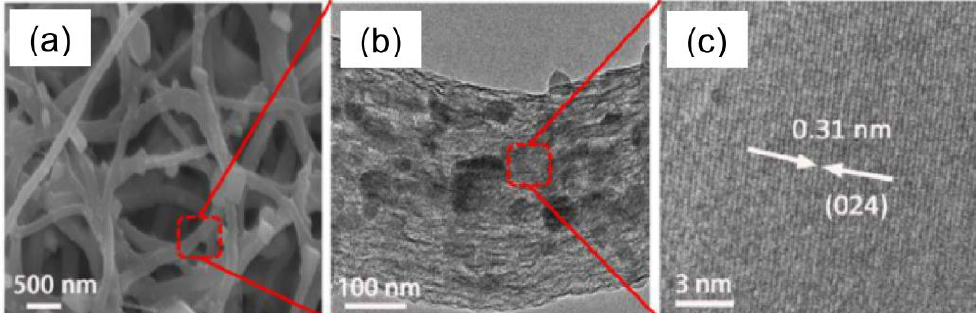
Figure 11. ( a ) SEM image of the free-standing membrane consisting of Na 3 V 2 (PO 4 ) 3 /carbon fibers. ( b ) TEM and ( c ) high-resolution TEM images of the composite fibers (reproduced from reference [127] with permission. Copyright 2017, 2017 Science Press and Dalian Institute of Chemical Physics, Chinese Academy of Sciences. Elsevier).